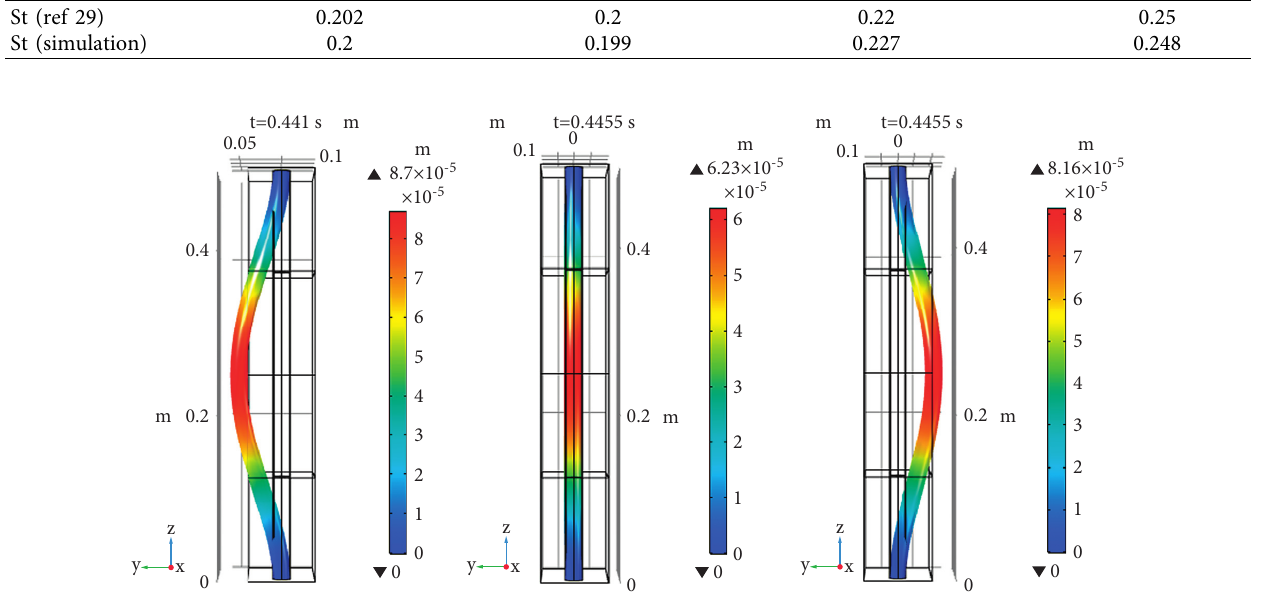
Figure 11: Displacement nephogram of tube bundle.